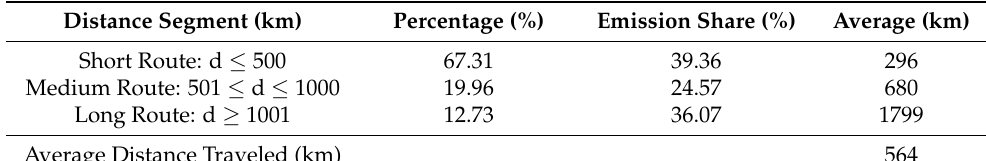
Table 5. Air corridor distribution on the travel distance 1 .